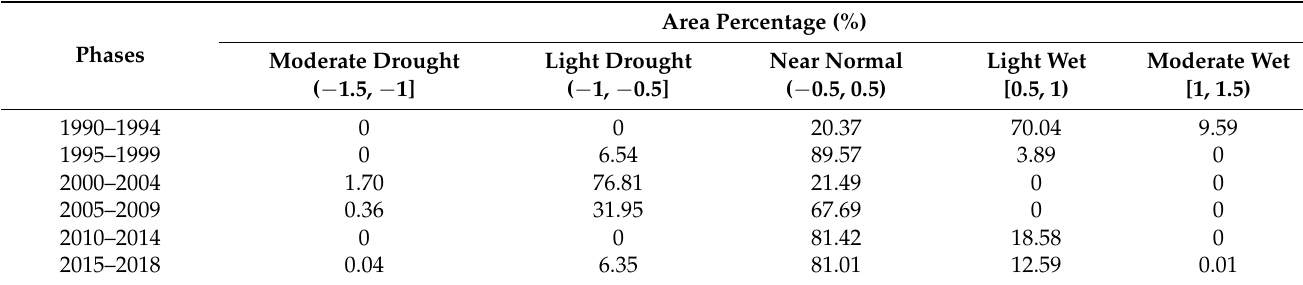
Table 3. Proportion of drought areas in northeast China (NEC) every five years from 1990 to 2018.